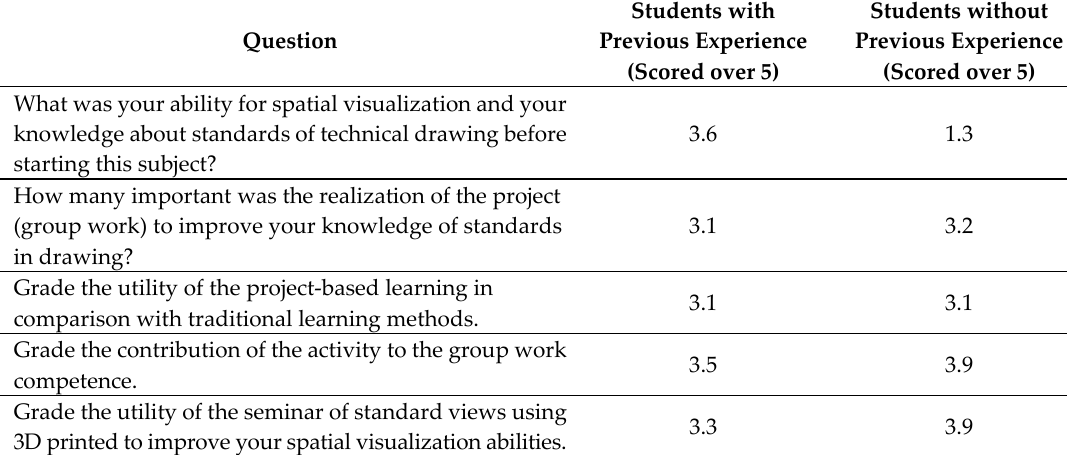
Table 1. Results of the satisfaction surveys about the group work and printed parts activity. Question